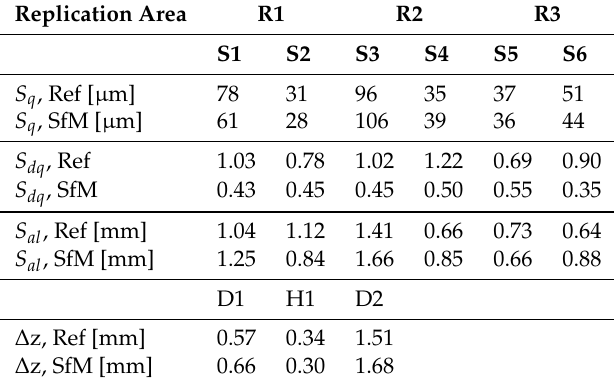
Figure 6. ( a – c ) Reference and ( d – f ) SfM DEMs of area R1, R2 and R3, respectively, with prior image processing as described in Section 2.6. Surface roughness regions S1 to S6 are indicated with solid blue lines. Depressions D1, D2 and ridge H1 are indicated with dashed red and dotted yellow lines, respectively. The scalebar is 5 mm. ( g – i ) Scatter plots of SfM and reference values for S q , S dq and S al , respectively. The dotted line indicates where SfM values are equal to reference values. Table 3. Quantitative values for surface roughness and topography features. The roughness parameters S q , S dq and S al for regions S1 to S6 were calculated using an S-filter of 25 µ m and an L-filter of 10 mm. The depth for depression areas D1 and D2 and height for ridge area